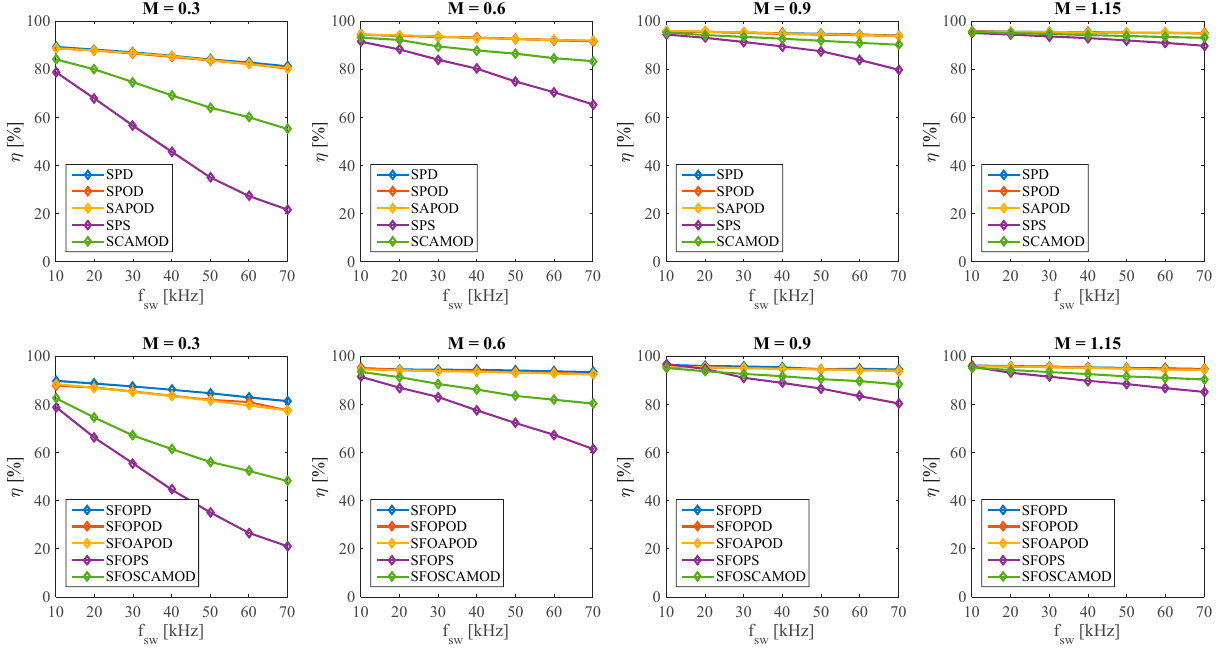
Figure 25. Comparison of the efficiency trend among modulation schemes with the same modulation signal.